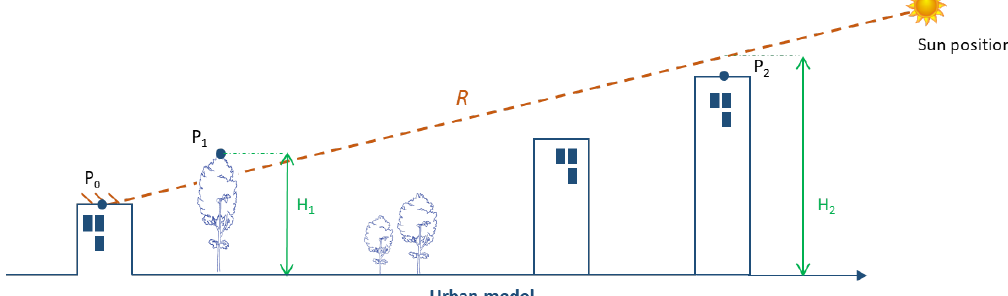
Figure 4. Concept of shadow casting algorithm adapted from [10]. In this example P 0 is shaded by P 1 , where the relative height ( H 1 ) is higher than the ray R , but not by P 2